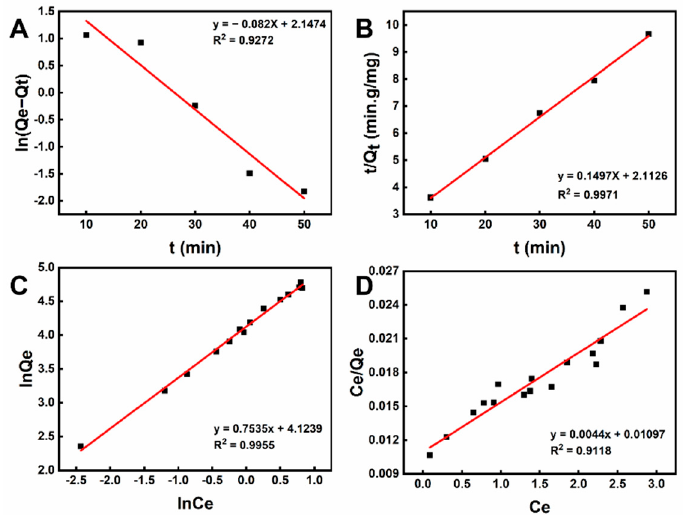
Figure 6. Adsorption simulation of CLIT with ( A ) quasi-first-order-kinetics; ( B ) quasi-second-order- kinetics; ( C ) Freundlich isotherm model; ( D ) Langmuir isotherm model. kinetics; ( C ) Freundlich isotherm model; ( D ) Langmuir isotherm model.